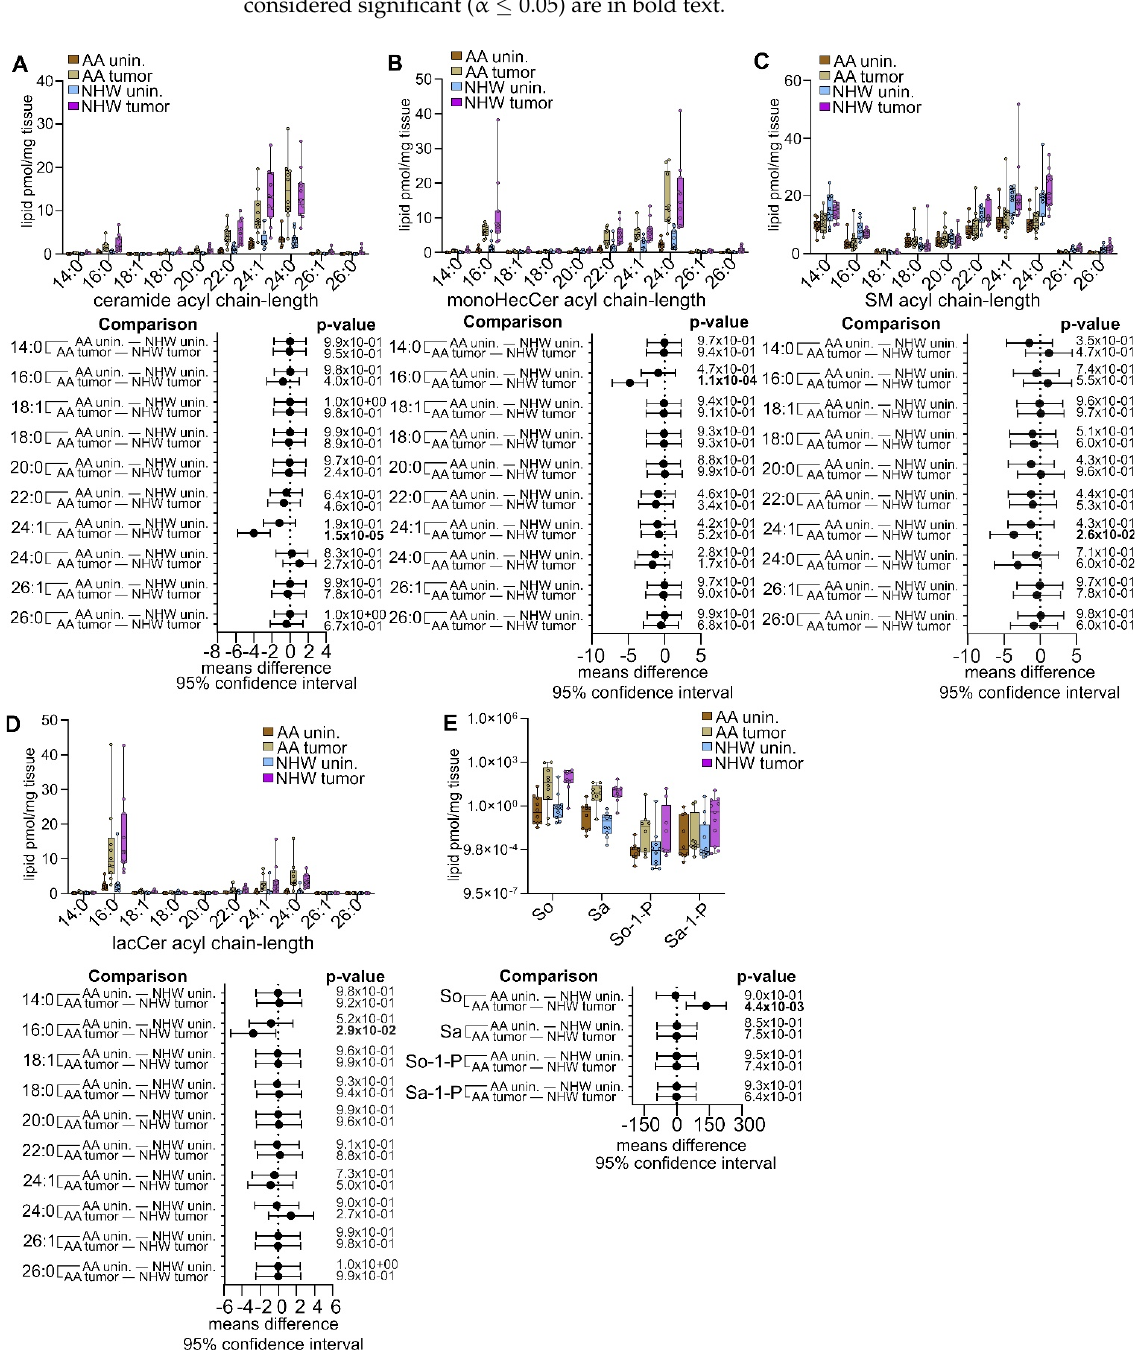
Figure 5. Secondary analysis comparisons of unin. vs. unin. and tumor vs. tumor sphingolipid profiles of self-identified AA and NHW females with EEC. Data presented in Figures 2E–H,V and 3E–H,V were analyzed to examine differences in the indicated lipids between unin. and tumor tissues of self-identified AA and NHW females with EEC. In each panel ( A – E ), the up- per graphs are box plots showing medians (black line) and whiskers of min to max (top), and the bottom graphs are plots of the 95% family-wise significance and confidence intervals for predicted means difference calculated following ANOVA. Corresponding unadjusted p -val- ues (Fisher’s LSD; Prism) for the indicated comparisons are shown to the right of the 95% confidence interval plots. The lower limit of p - and q-value calculations was set to 1.0 × 10 -15 (Prism), so no values are reported lower than this limit. For p -adjusted (q) values corrected for